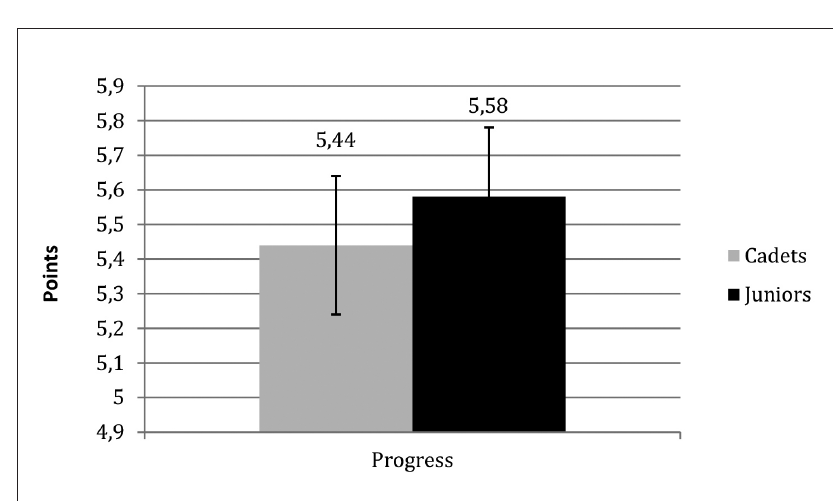
Figure 3. Mean scores in progress